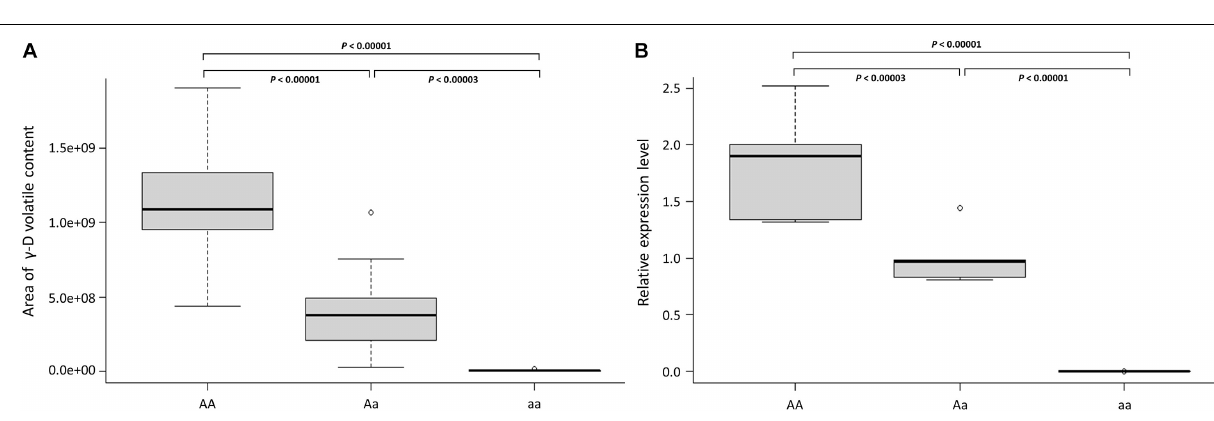
FIGURE 5 | Differentiation of homo- and heterozygous γ -D producers using codominant HRM and KASP markers, NGD001 and UFGDKASP. (A) The pattern of HRM melting curve for HRM marker, NGD001, in 48 accessions. (B) Endpoint genotyping analysis of KASP marker, UFGDKASP, in 48 accessions. AA: homozygote γ -D producer, Aa: heterozygote γ -D producer, aa: homozygote γ -D non-producer.